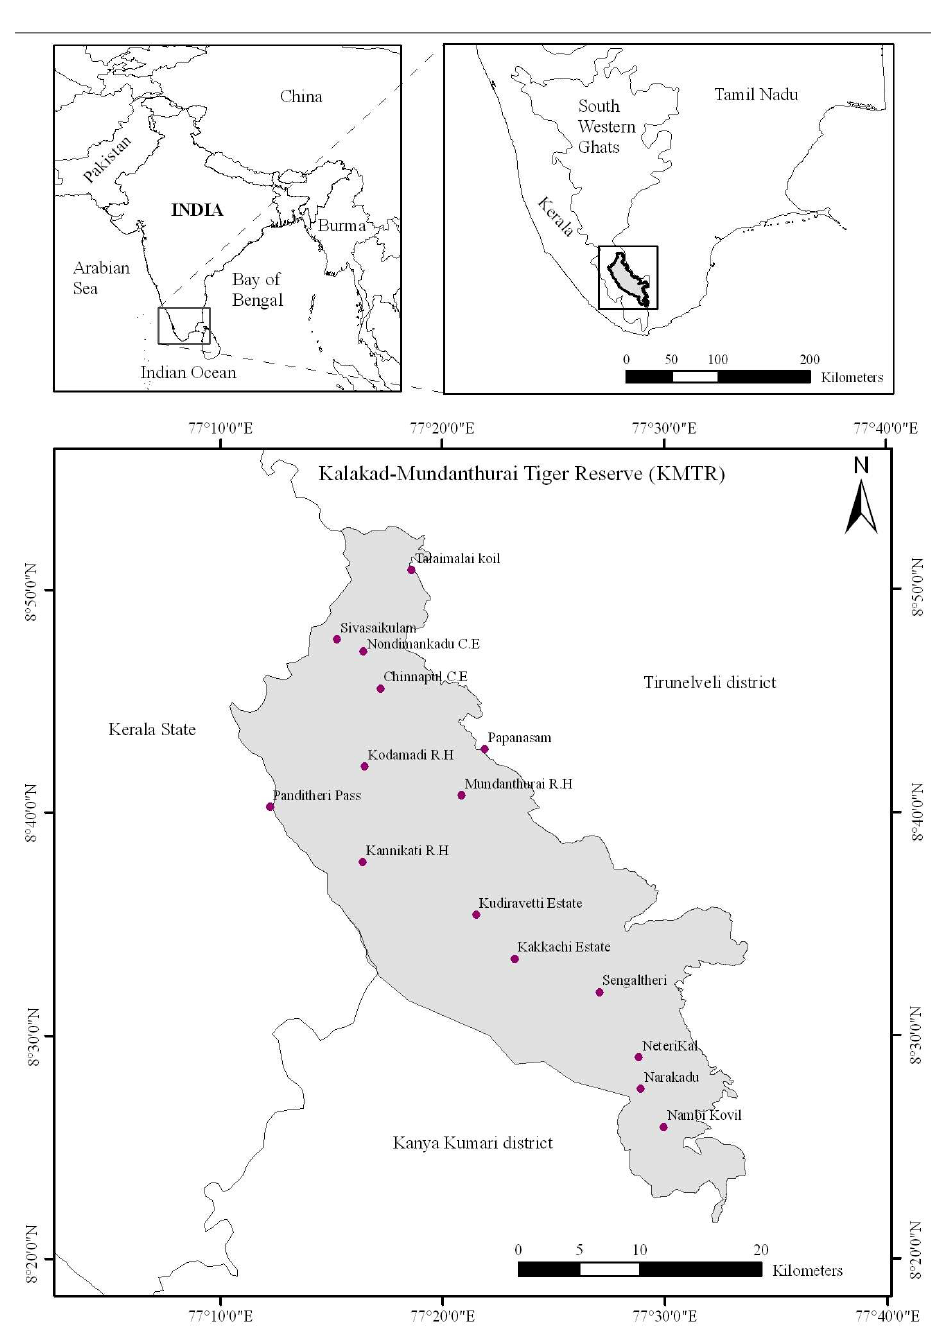
Figure 1. Geographic position of the Kalakad–Mundanthurai Tiger Reserve (KMTR), South Western Ghats, located in the Tirunelveli and Kanykumari districts of Tamil Nadu,